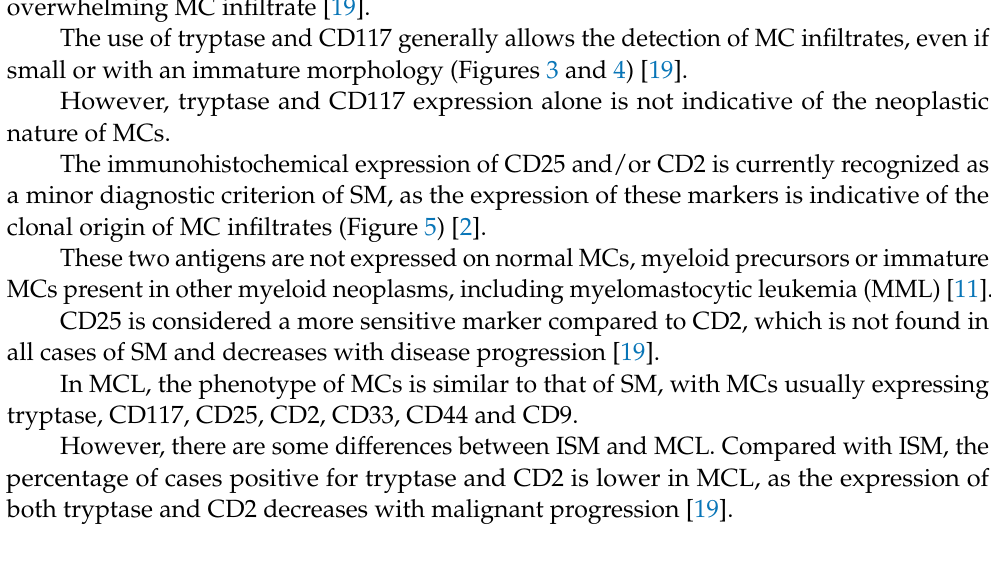
Figure 3. Medium power view of BM infiltrate highlighted by diffuse and intense CD117 positivity (CD117 immunostaining, magnification 100×; original image from Prof. S.A.).